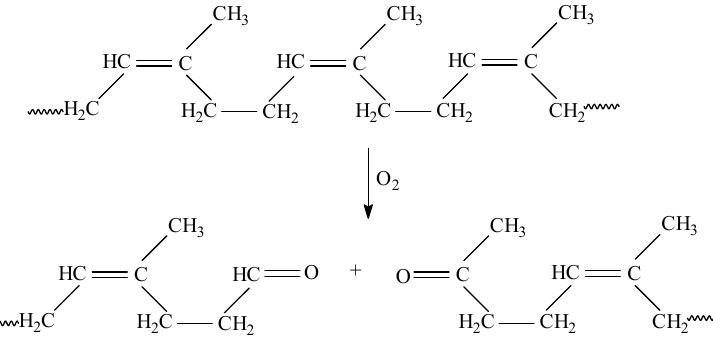
Figure 11. Biodegradation reaction mechanism of natural rubber.